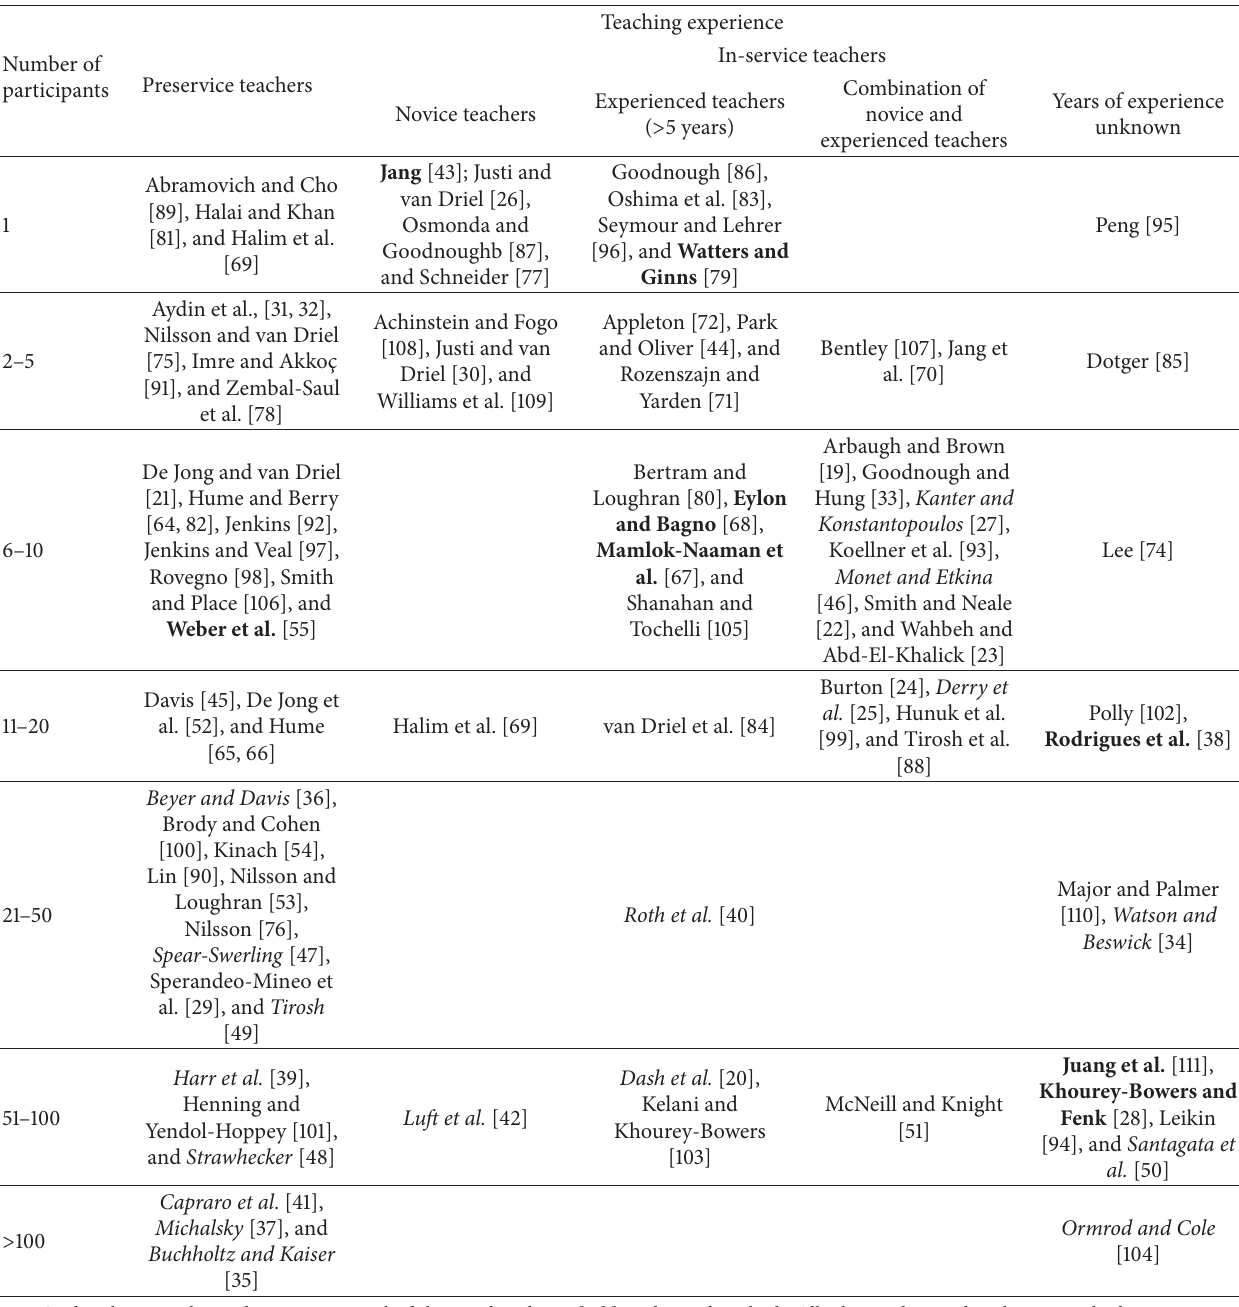
Table 2: Overview of participants and research